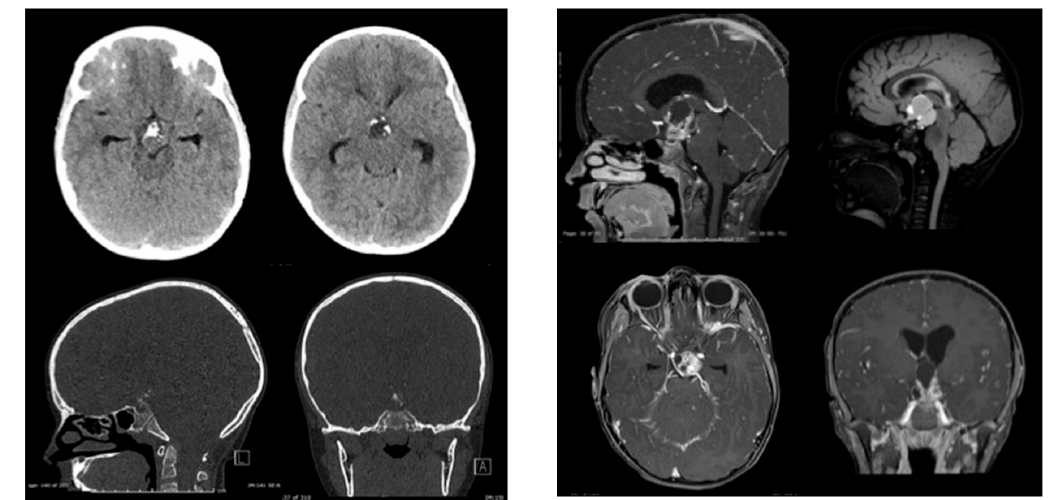
Figure 2. Computed Tomography ( Left ) andMagnetic resonance Imaging ( Right ) images from the same patient of a classic example of an adamantinomatous craniopharyngioma. This typical tumor is centered in the suprasellar region with mixed solid and cystic areas as well as areas of calcification as seen on the CT.